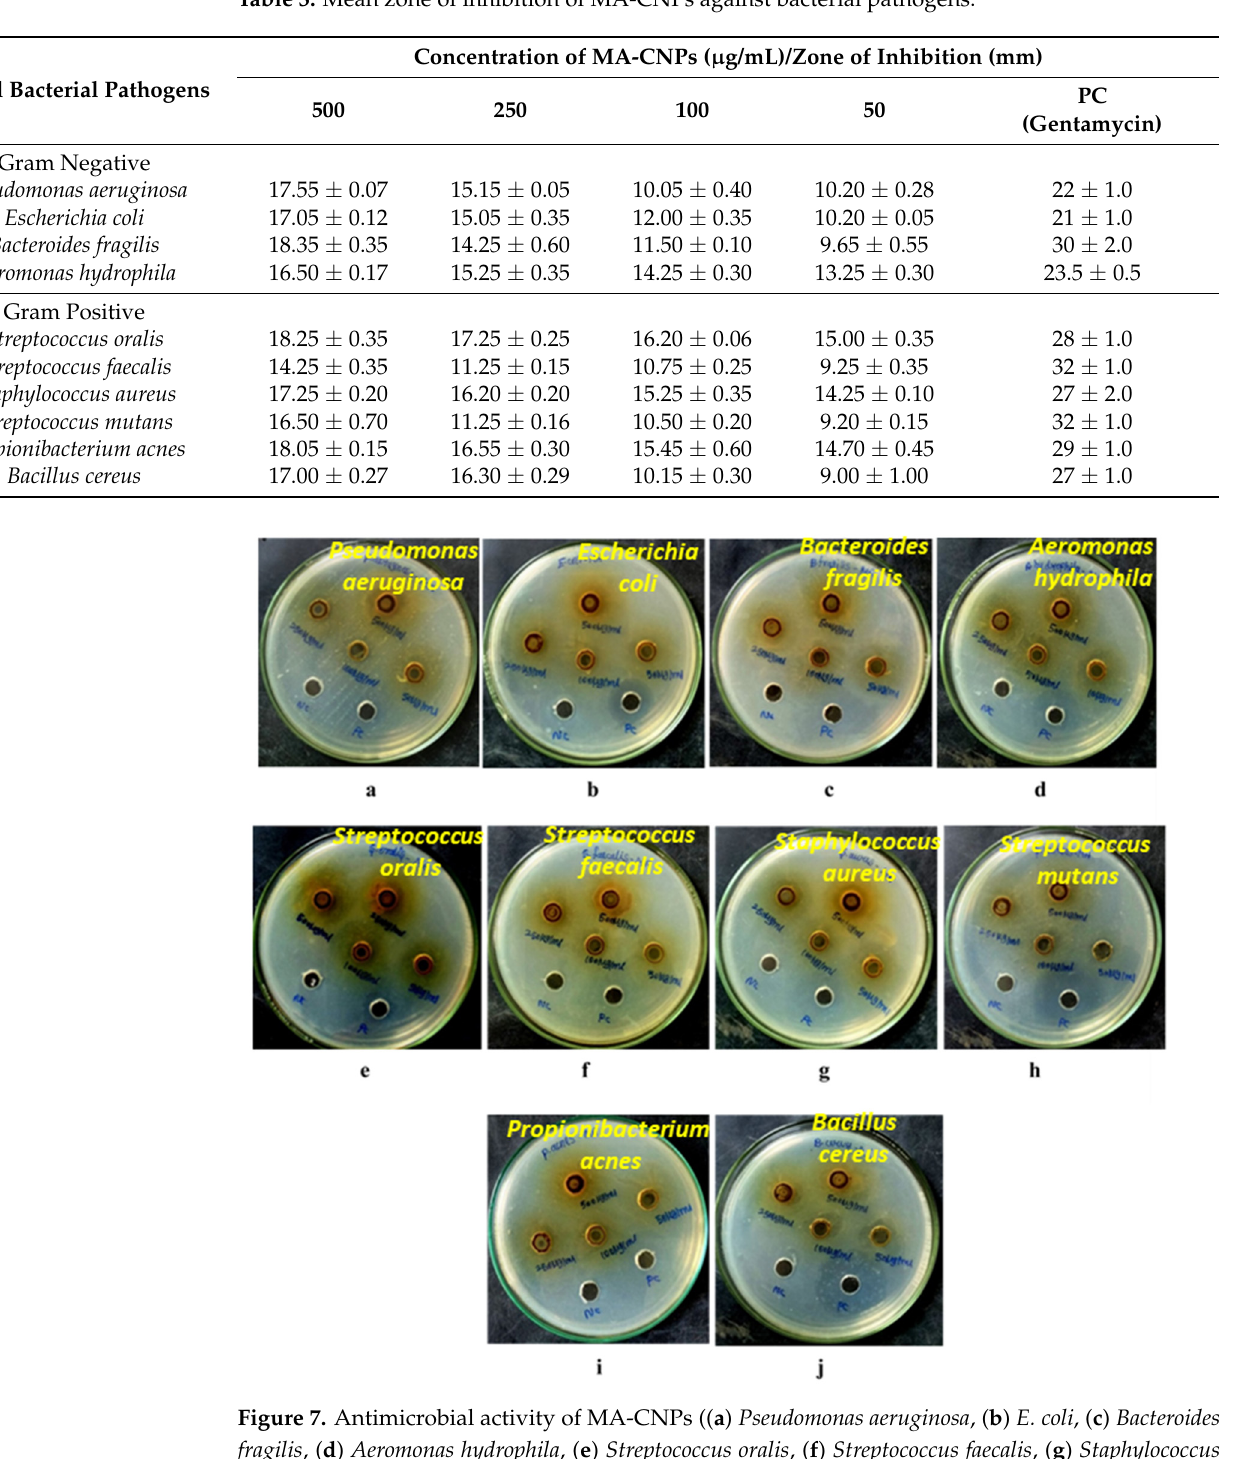
Table 3. Mean zone of inhibition of MA-CNPs against bacterial pathogens.